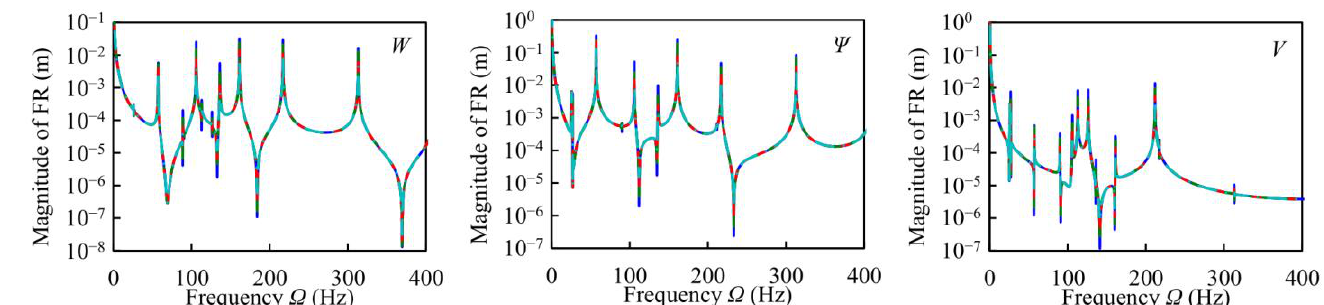
Figure 8. Effect of the stiffness of the subsystem on the frequency response at the right end of the thin-walled beam ( k si = 3333.33/2 kN/m, k si = 3333.33 kN/m, k si = 3333.33 × 2 c si kN/m, k si =3333.33 × 4 kN/m).